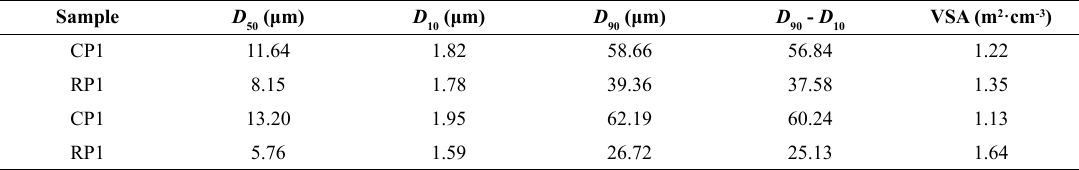
), amplitude of distribution ( D 50